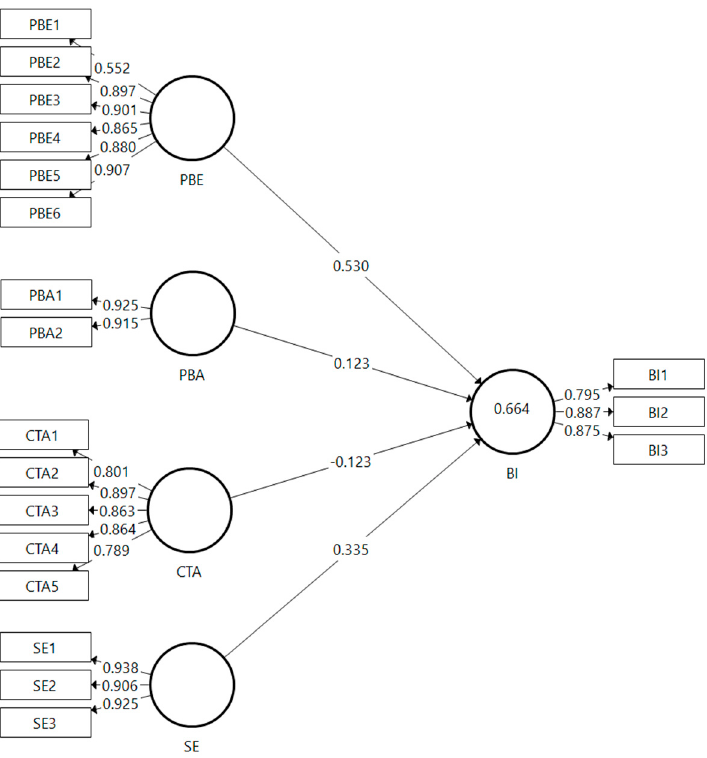
Figure 1. Model Assessment.